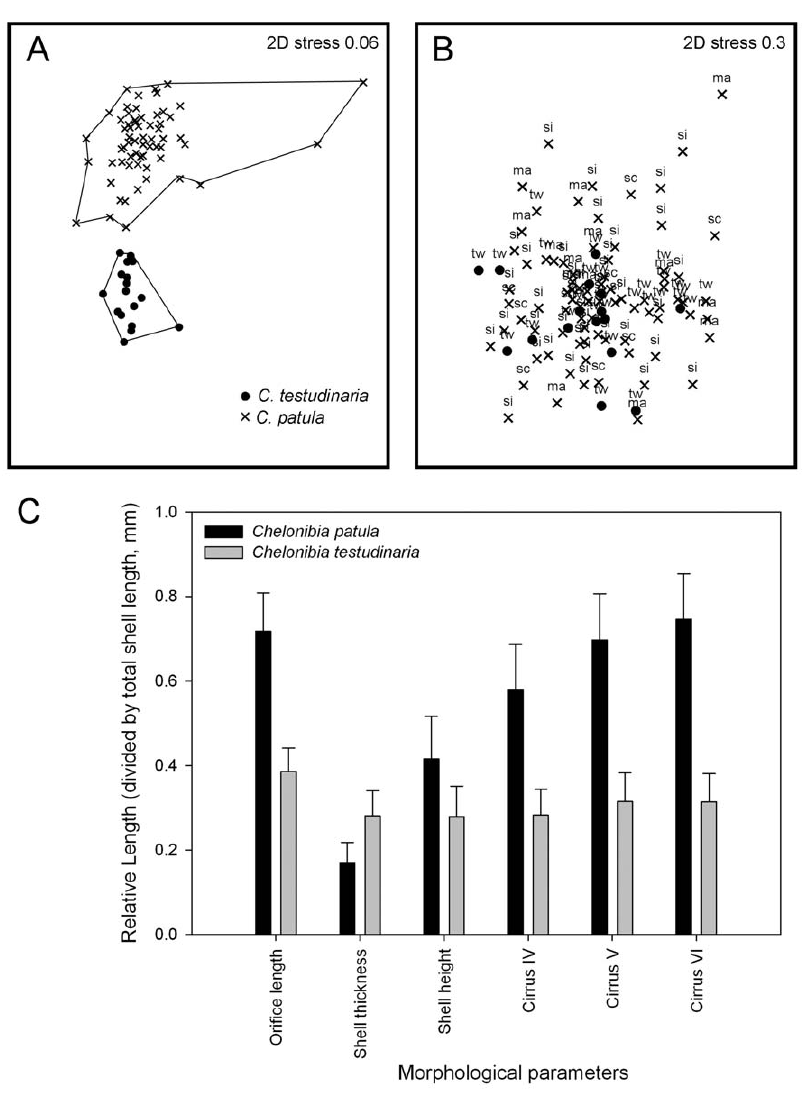
Figure 2. A. nMDS plots showing ordinations of the morphological characters of Chelonibia patula and C. testudinaria . B. nMDS plots showing the AFLP analysis of C. patula and C. testudinaria . Refer to table 2 for the acronyms of the population. C. Mean ( 6 SD), of the shell parameters and cirrus length (relative to the total shell length) of C. patula and C. testudinaria .